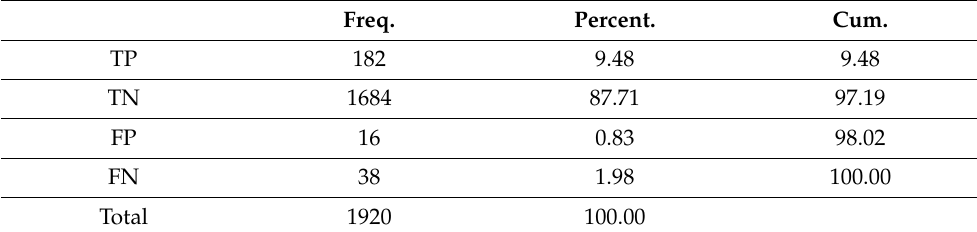
Table 1. TP, TN, FP and FN values calculated for each group (teeth, implants, crowns, fillings, residual roots and root canal treatments). Freq. Percent.